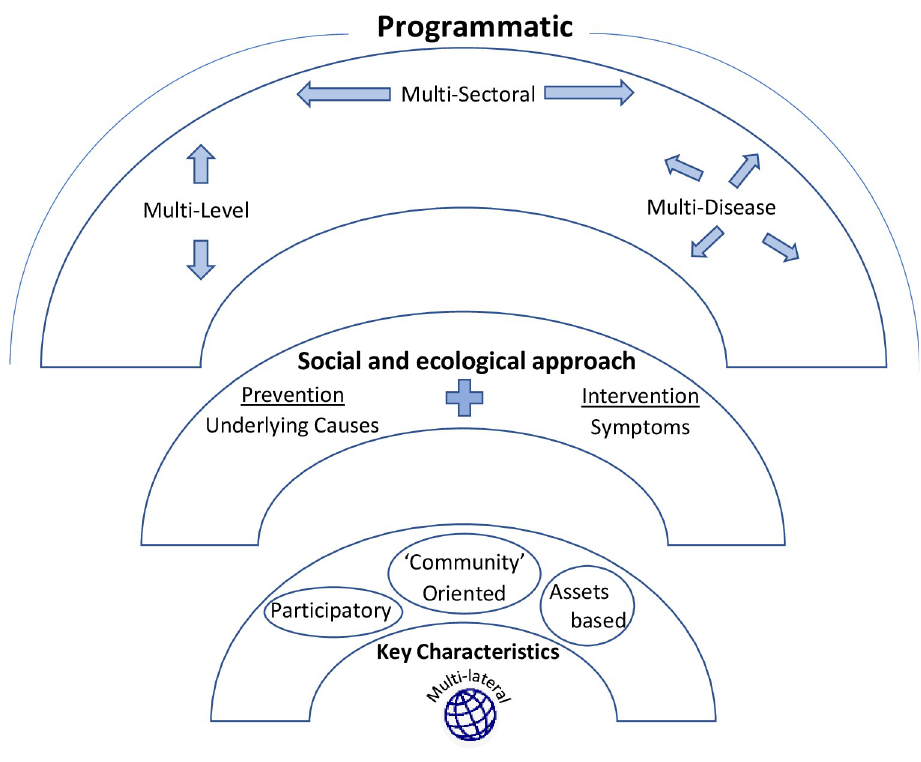
Fig 2. Framework for best